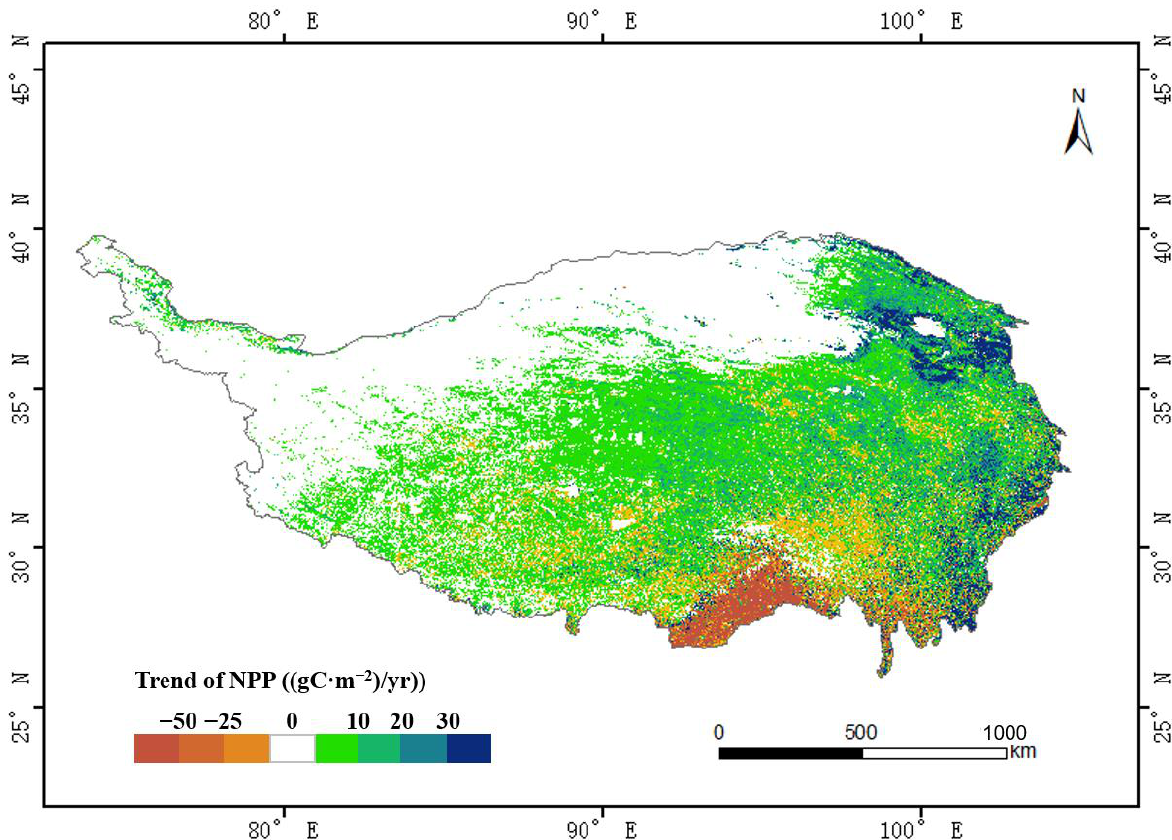
Figure 5. Spatial distribution of the trend of NPP over the QTP from 2001 to 2017. The CV of NPP in QTP was obtained by Equation (3) in Section 2.2.3. The results are shown in Figure 6. The NPP in the lake, snow and northwest desert areas were 0 gC · m − 2 all year round, so the CV of NPP in the above areas were also 0. The CV values of Southern QTP and the boundary between desert and non-desert areas were large, which showed that NPP fluctuated greatly in those regions. In order to further quantitatively understand the distribution of CV of NPP in the QTP, we calculated the proportions of different CV of NPP (Table 2). In 34.9% of the area of the QTP (including desert, lake and snow), the CV of NPP was 0. In the high-cold vegetation area, NPP changed greatly, and CV values were mostly above 0.14. The CV of grassland area was smaller than that of other regions,